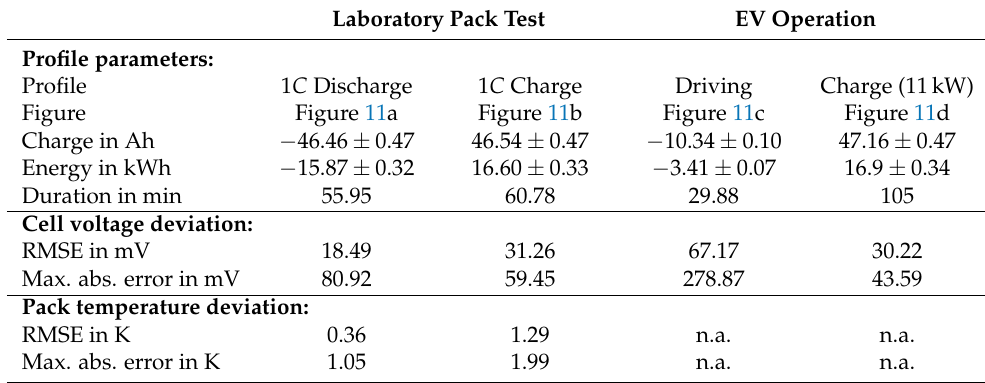
Table 8. Summary of validation profile parameters and simulation deviations.